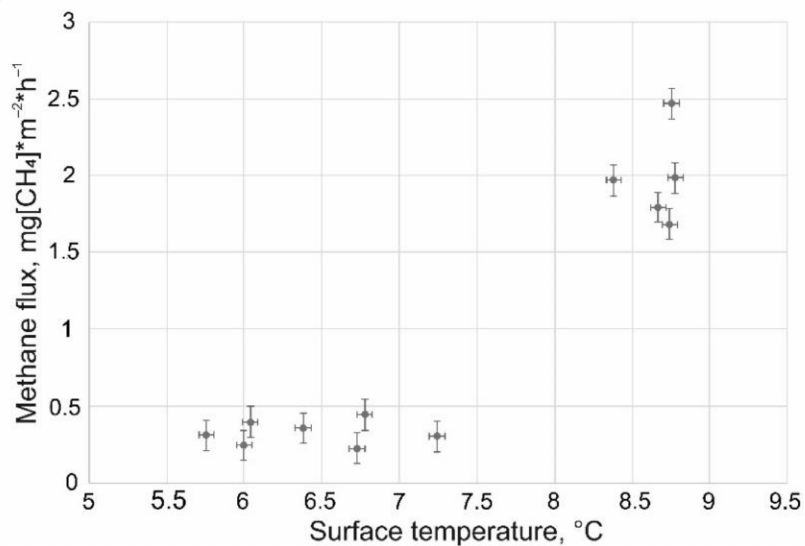
Figure 10. Methane fluxes with surface air temperature (July–August 2018), PB landscape, site